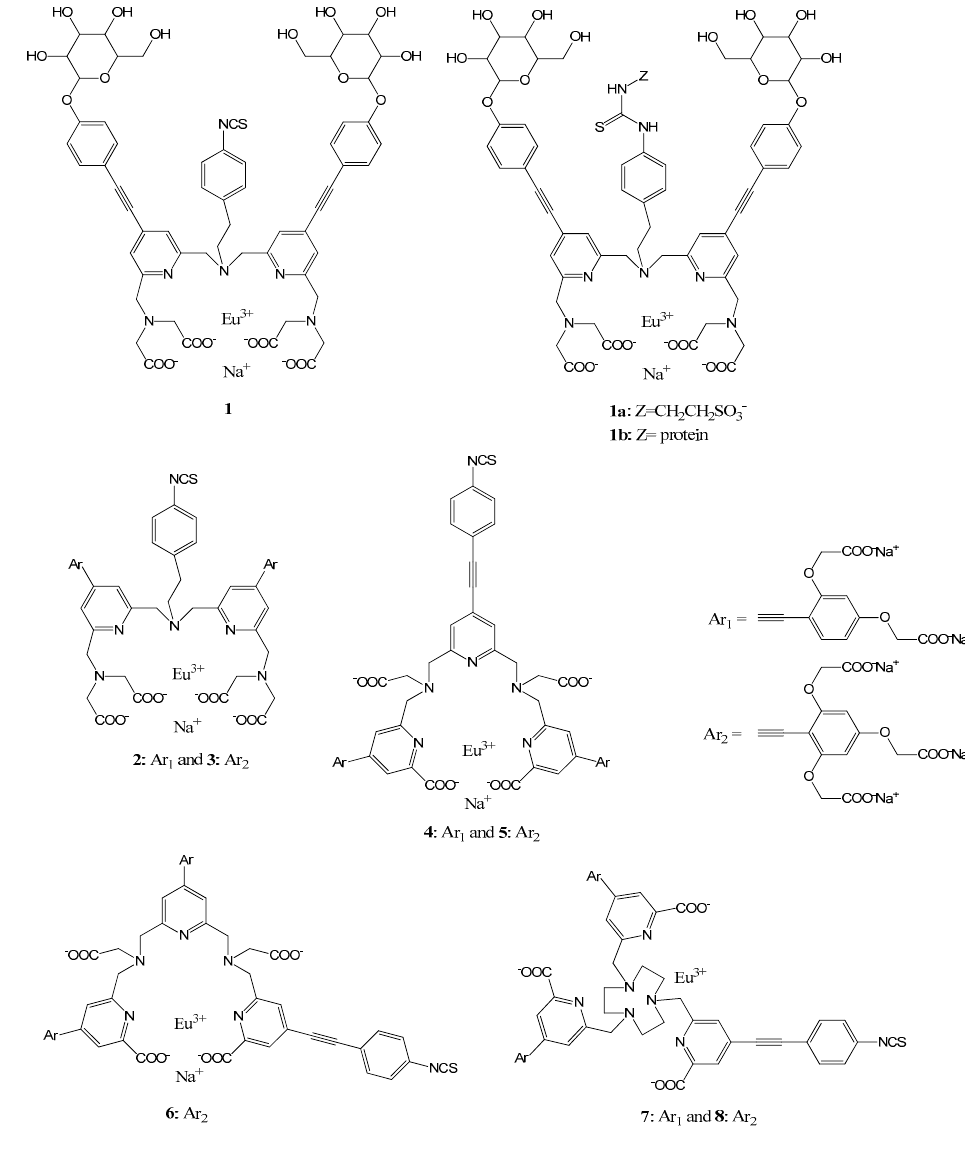
Scheme 1. The studied label structures numbered 1 – 8 .